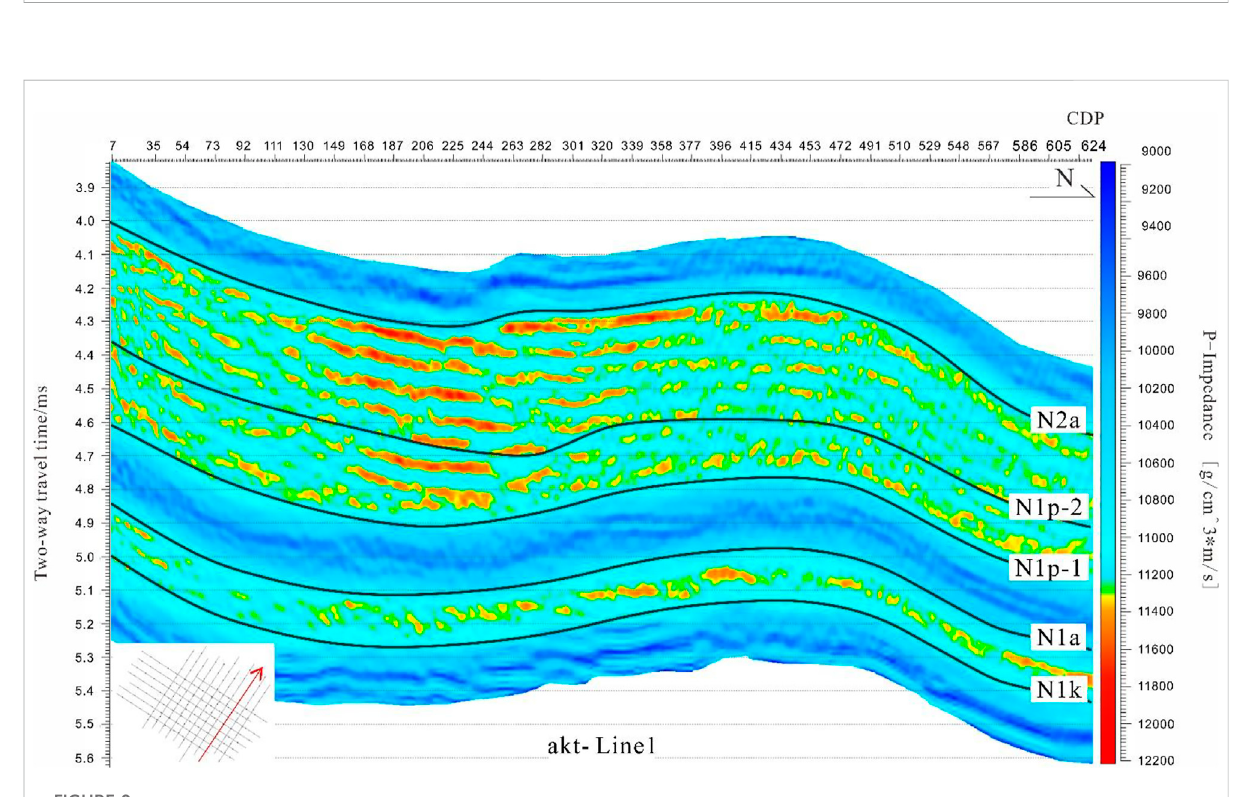
FIGURE 9 Wave impedance inversion pro fi le of Miocene strata in the Aketao